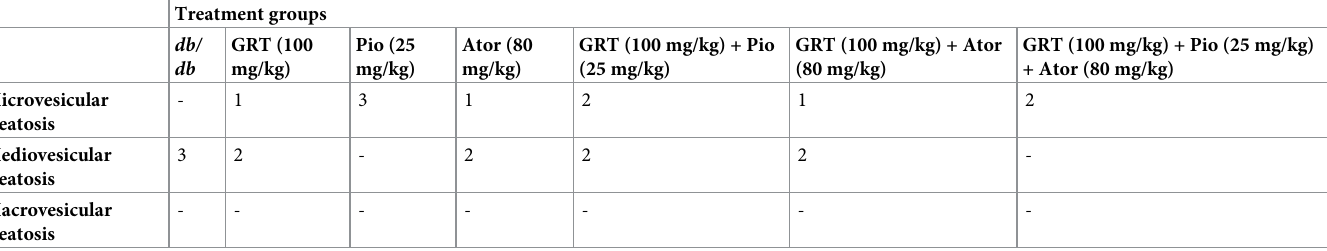
Table 2. Histological steatotic scoring. Treatment